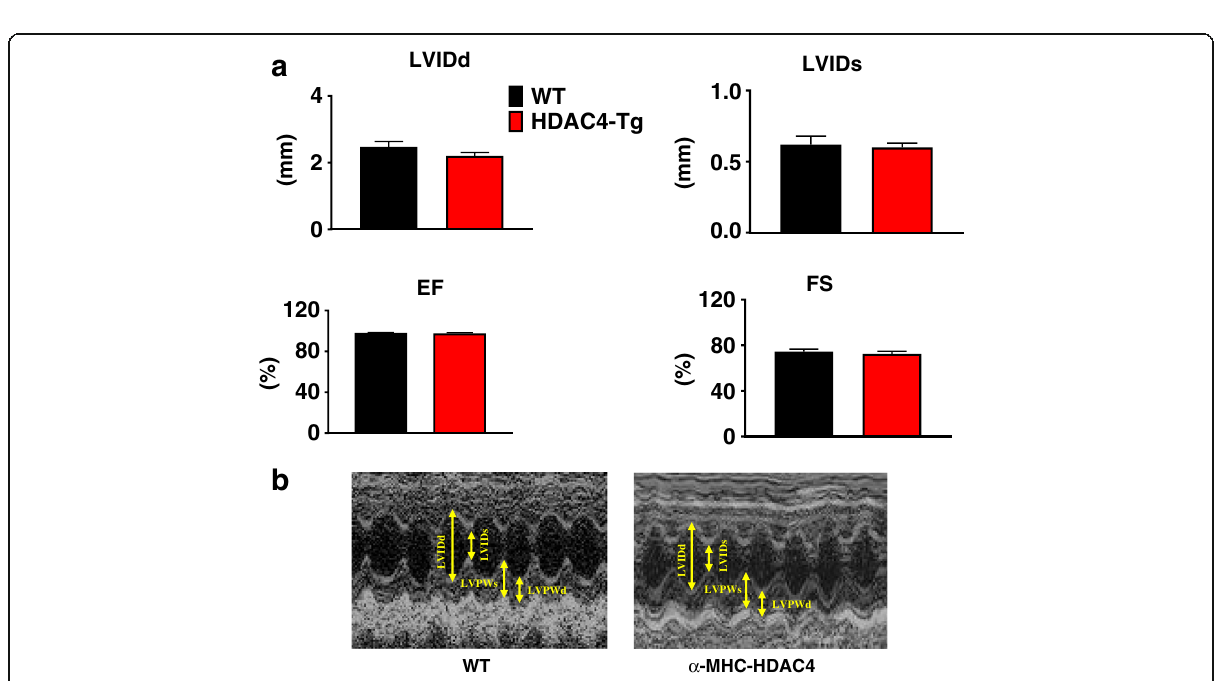
Fig. 2 Myocardial function of α -MHC-HDAC4 mice and wild type littermates. a Echocardiographic measurements of cardiac function from α -MHC-HDAC4 mice and wild type mice. Values represent mean±SE ( n =5/per group). EF: Ejection fraction; FS: Fractional shortening; LVID: left ventricle internal diameter; b Representative image of M-Mode of echocardiographic